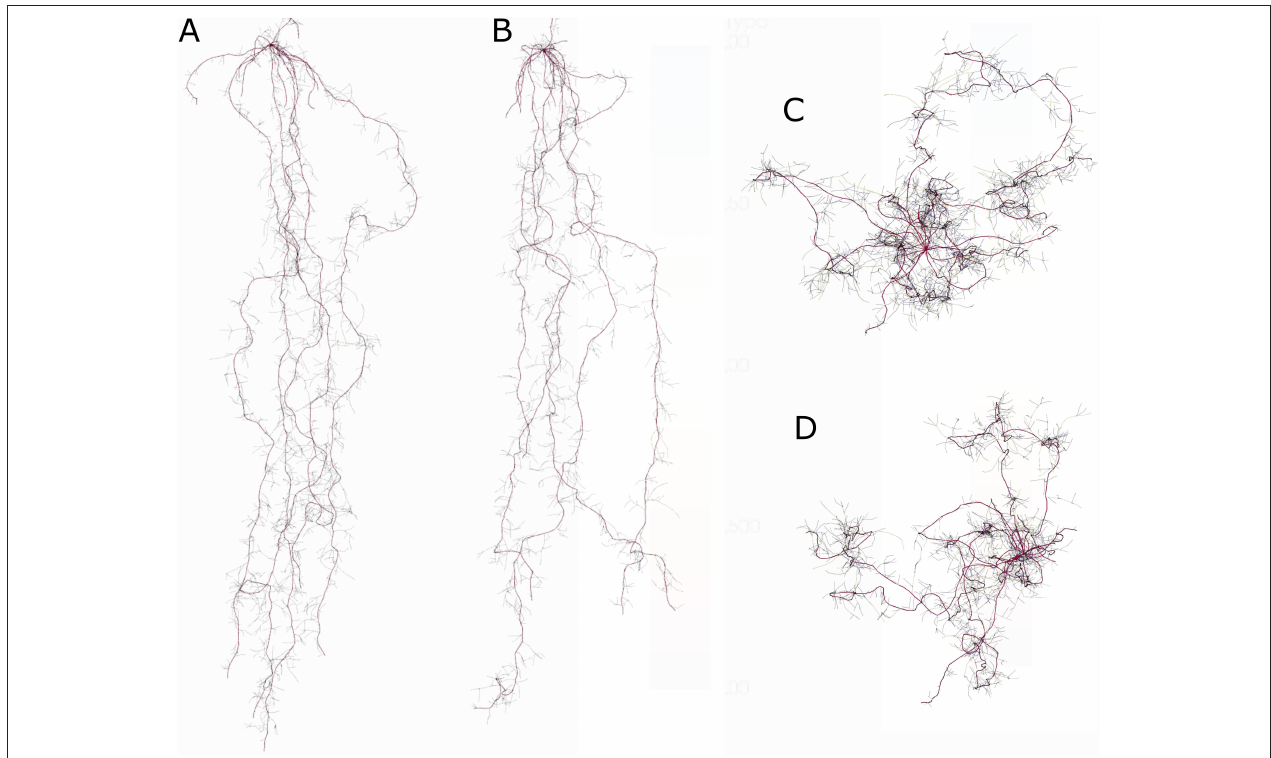
FIGURE 5 | Simulated winter wheat root system (treatment DL) at flowering in 2019/20 for the default ln parameter of 2 [side view (A) and top view (C) ] and for a high ln parameter of 2.5 [side view (B) and top view (D) ] using the coupled SIMPLACE-CRootbox model. Extension of root systems: to 183 from soil depth for ln = 2 and 0–180cm from soil depth for ln = 2.5cm. Red color: root of first order, blue color: root of second order.